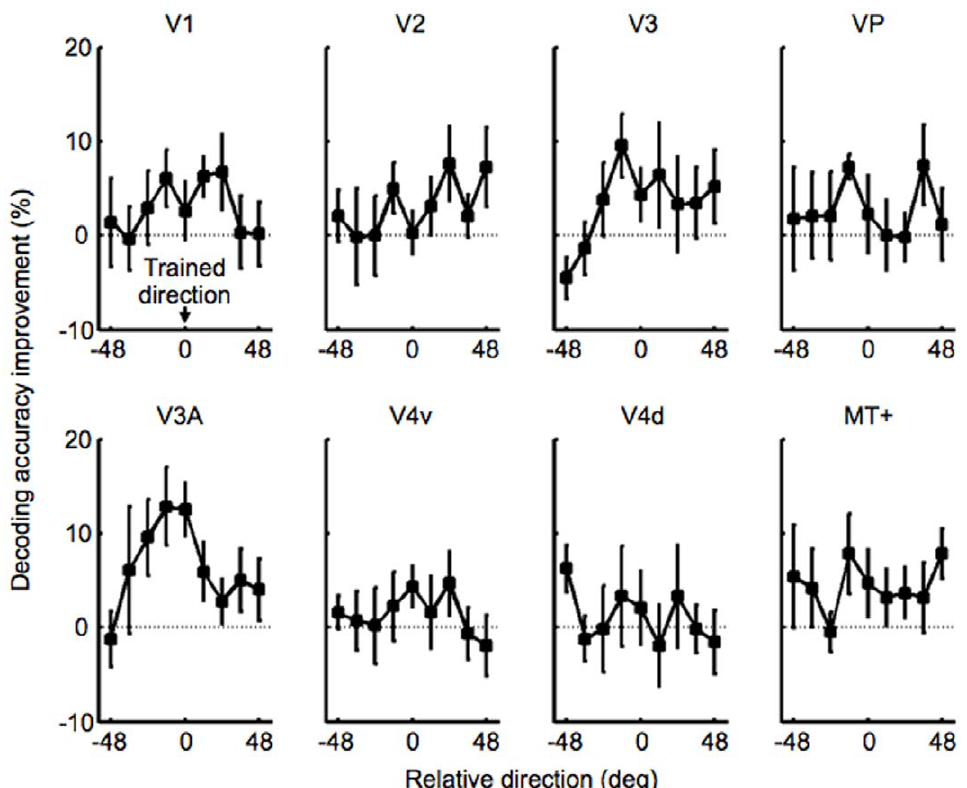
Figure 3. A decoded tuning improvement function for each ROI. Mean decoding performance improvement across the subjects was calculated by subtracting decoding accuracy in the pre-fMRI stage from that in the post-fMRI stage for each of 9 motion directions. Significant improvement for the trained direction was obtained only in V3A (paired t-test, P , 0.05, false discovery rate, corrected by the number of the ROIs). Error bars represent